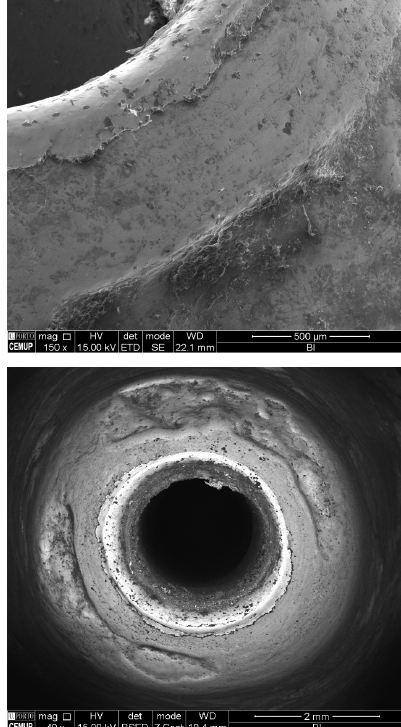
Figure 18. SEM analysis to the